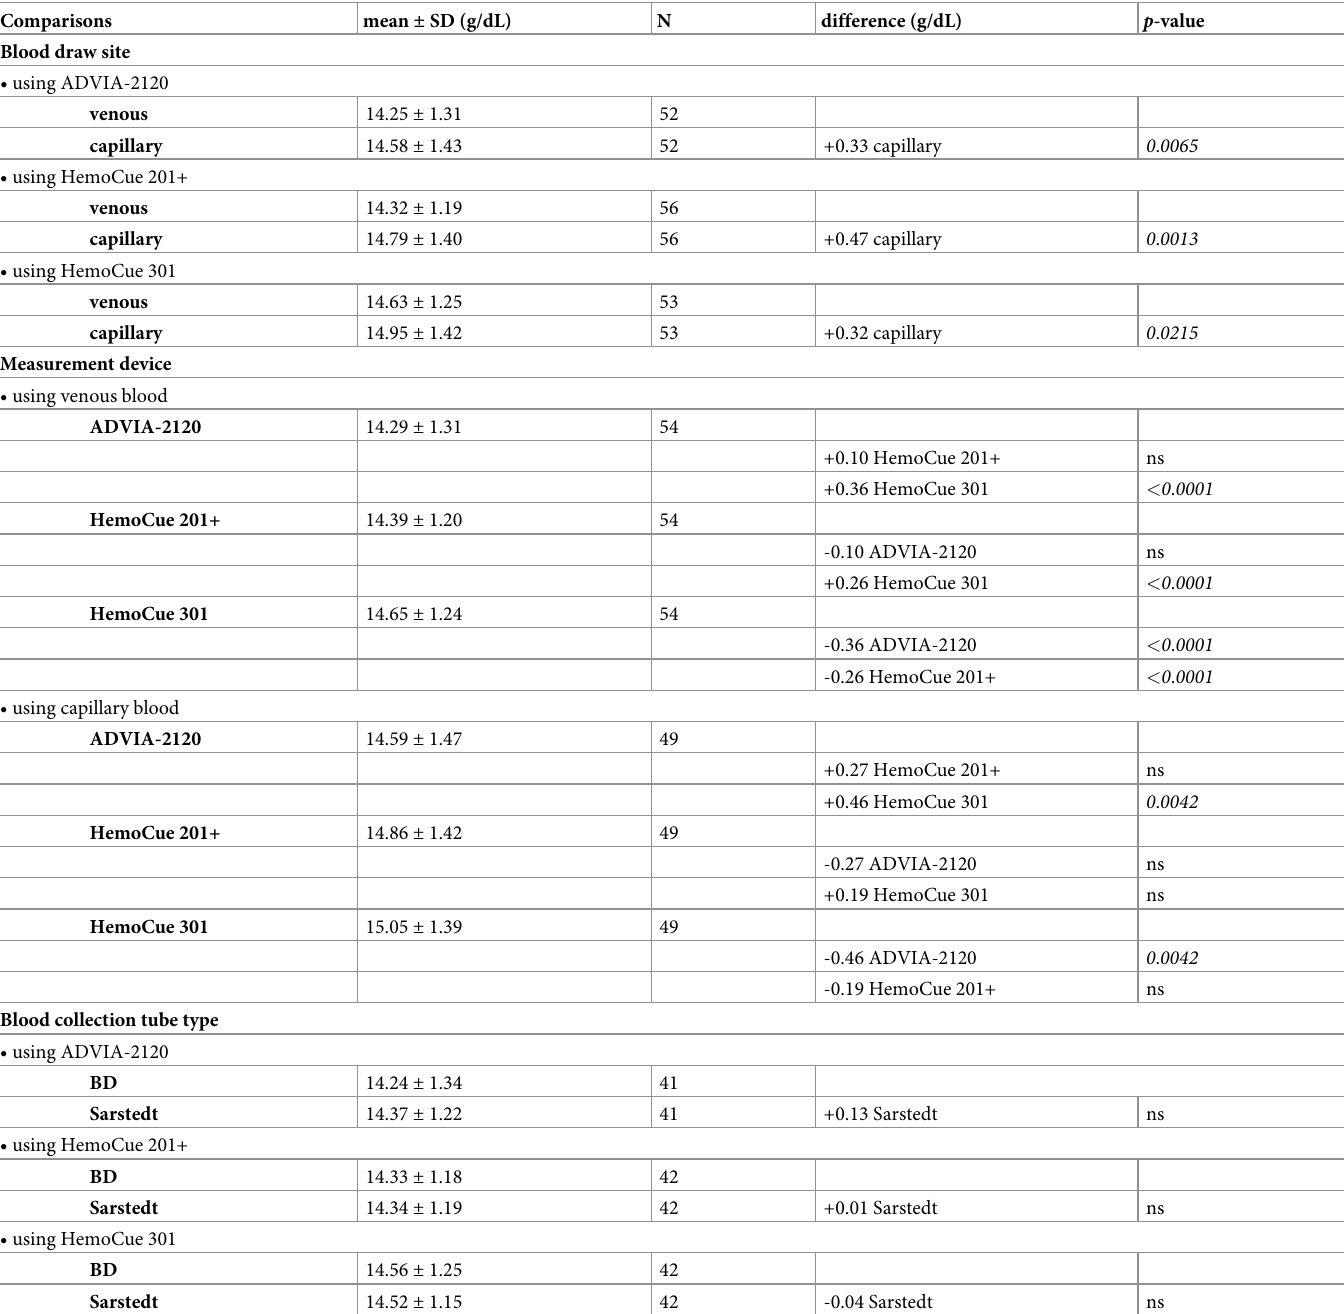
Table 2. Hemoglobin measurements differ by blood draw site and measurement device, but not blood collection tube manufacturer.